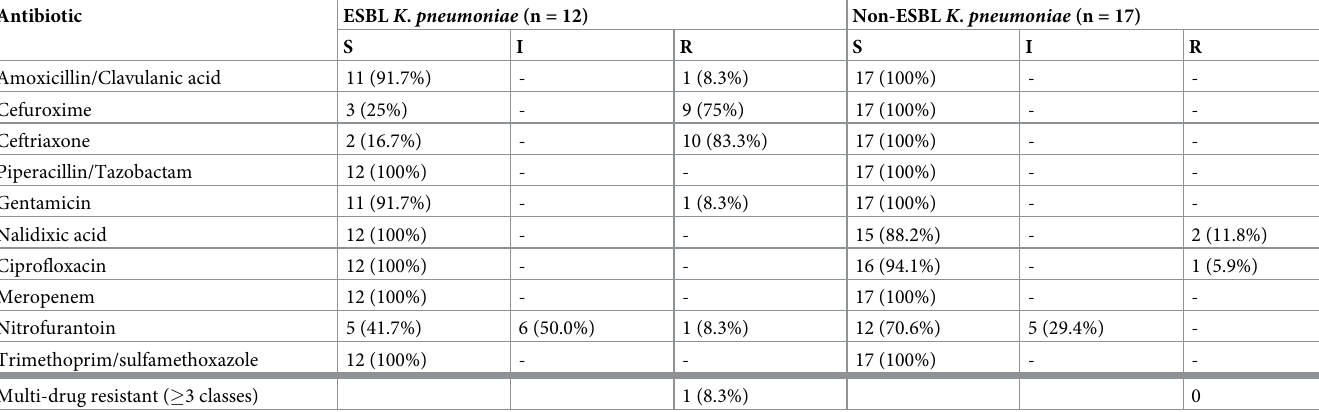
Table 4. Antimicrobial resistance patterns of K . pneumoniae isolates by ESBL positivity.